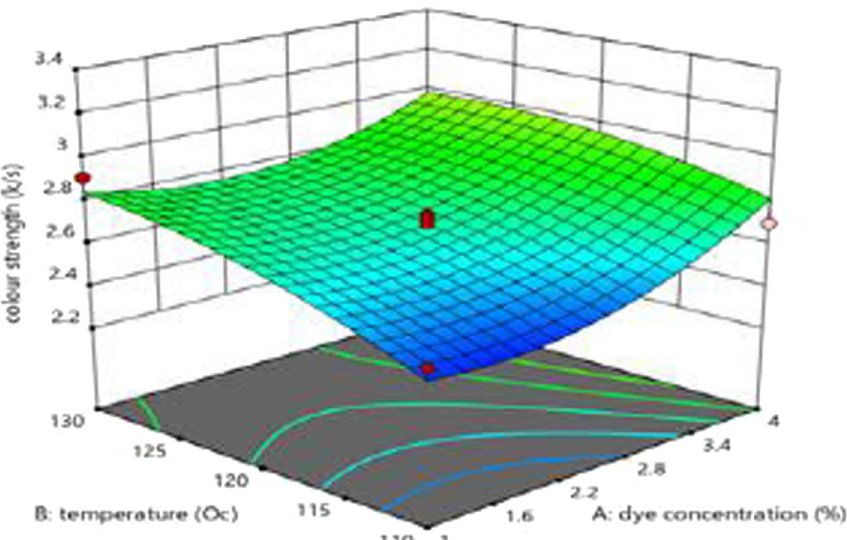
Fig. 7 Effect of dye concentra- tion and temperature on color